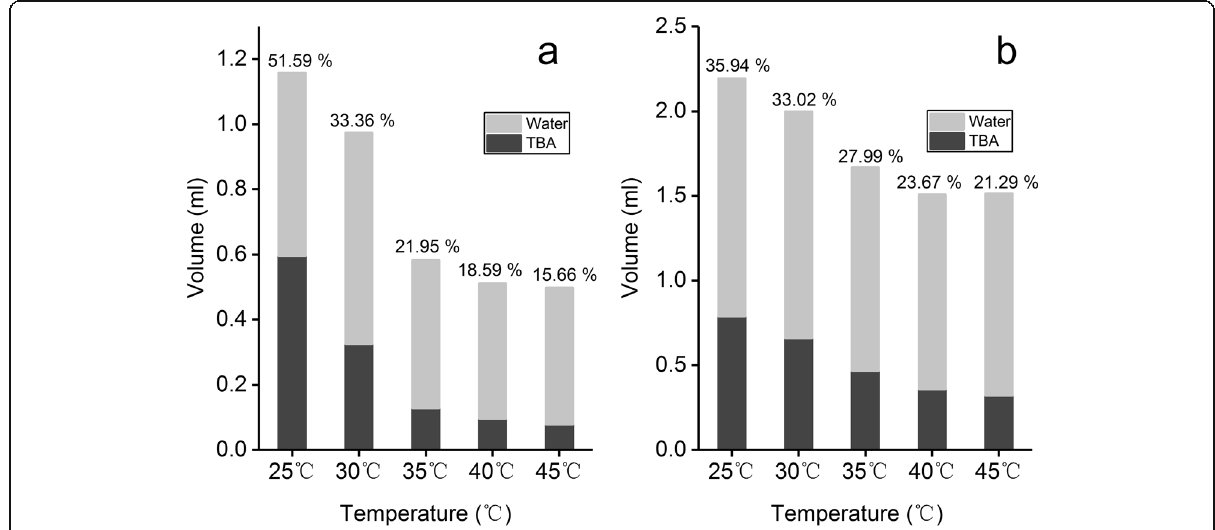
Fig. 2 Solubility of SPC ( a ) and cholesterol ( b ) in TBA/water co-solvent with different volume percentage